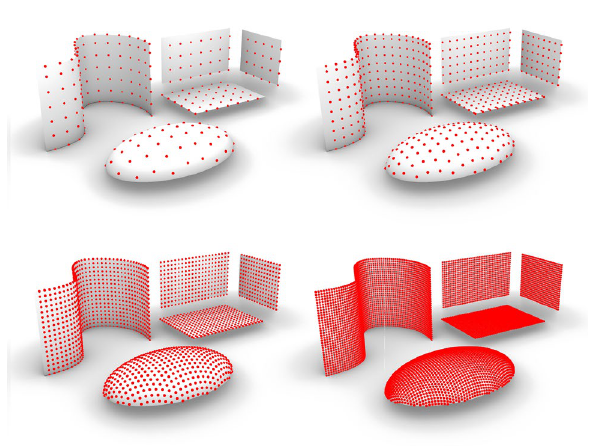
Figure 5. Discretization of surfaces by equidistant